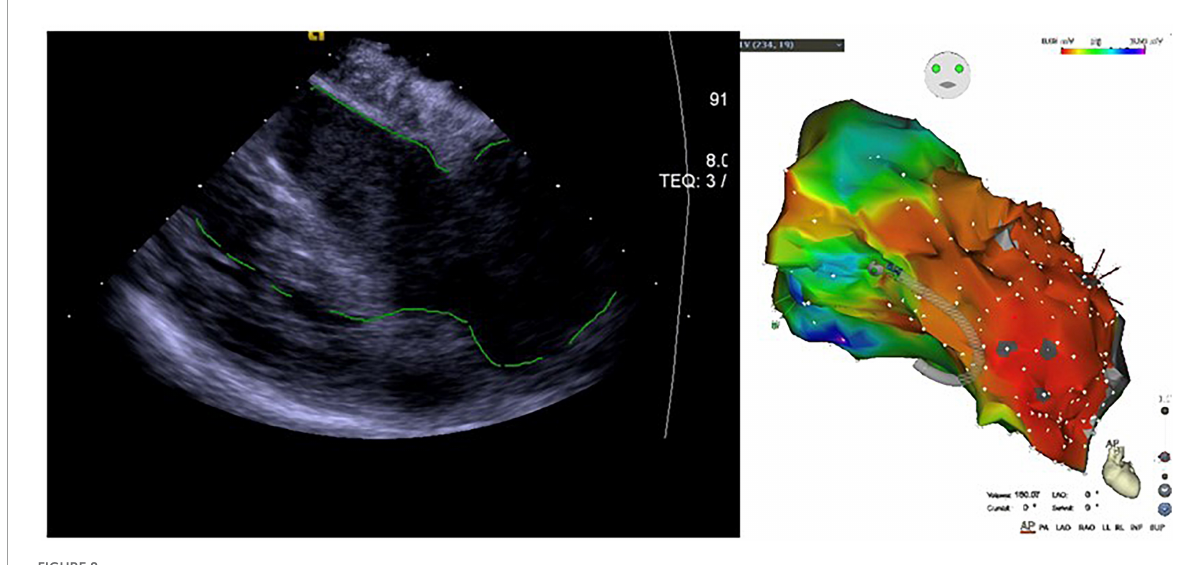
FIGURE8 Application of ICE in ischemic cardiomyopathy with ventricular aneurysm-induced ventricular